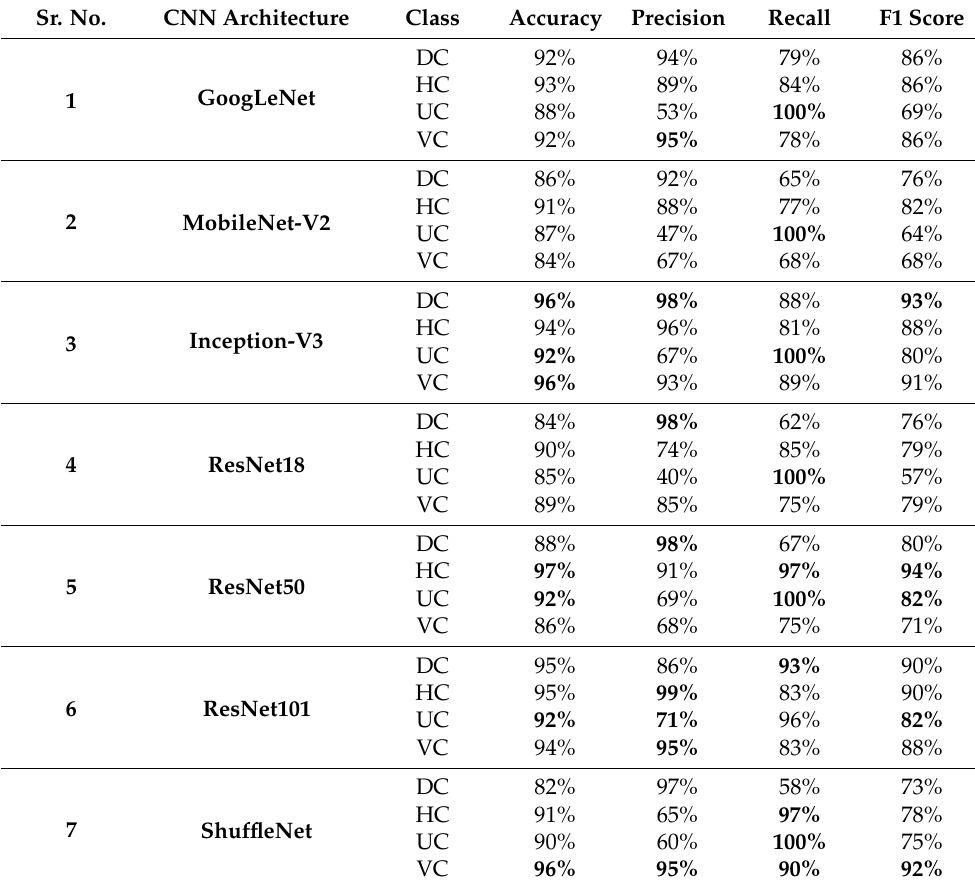
Table 3. Results for accuracy, precision, recall, and F1 score. Sr.